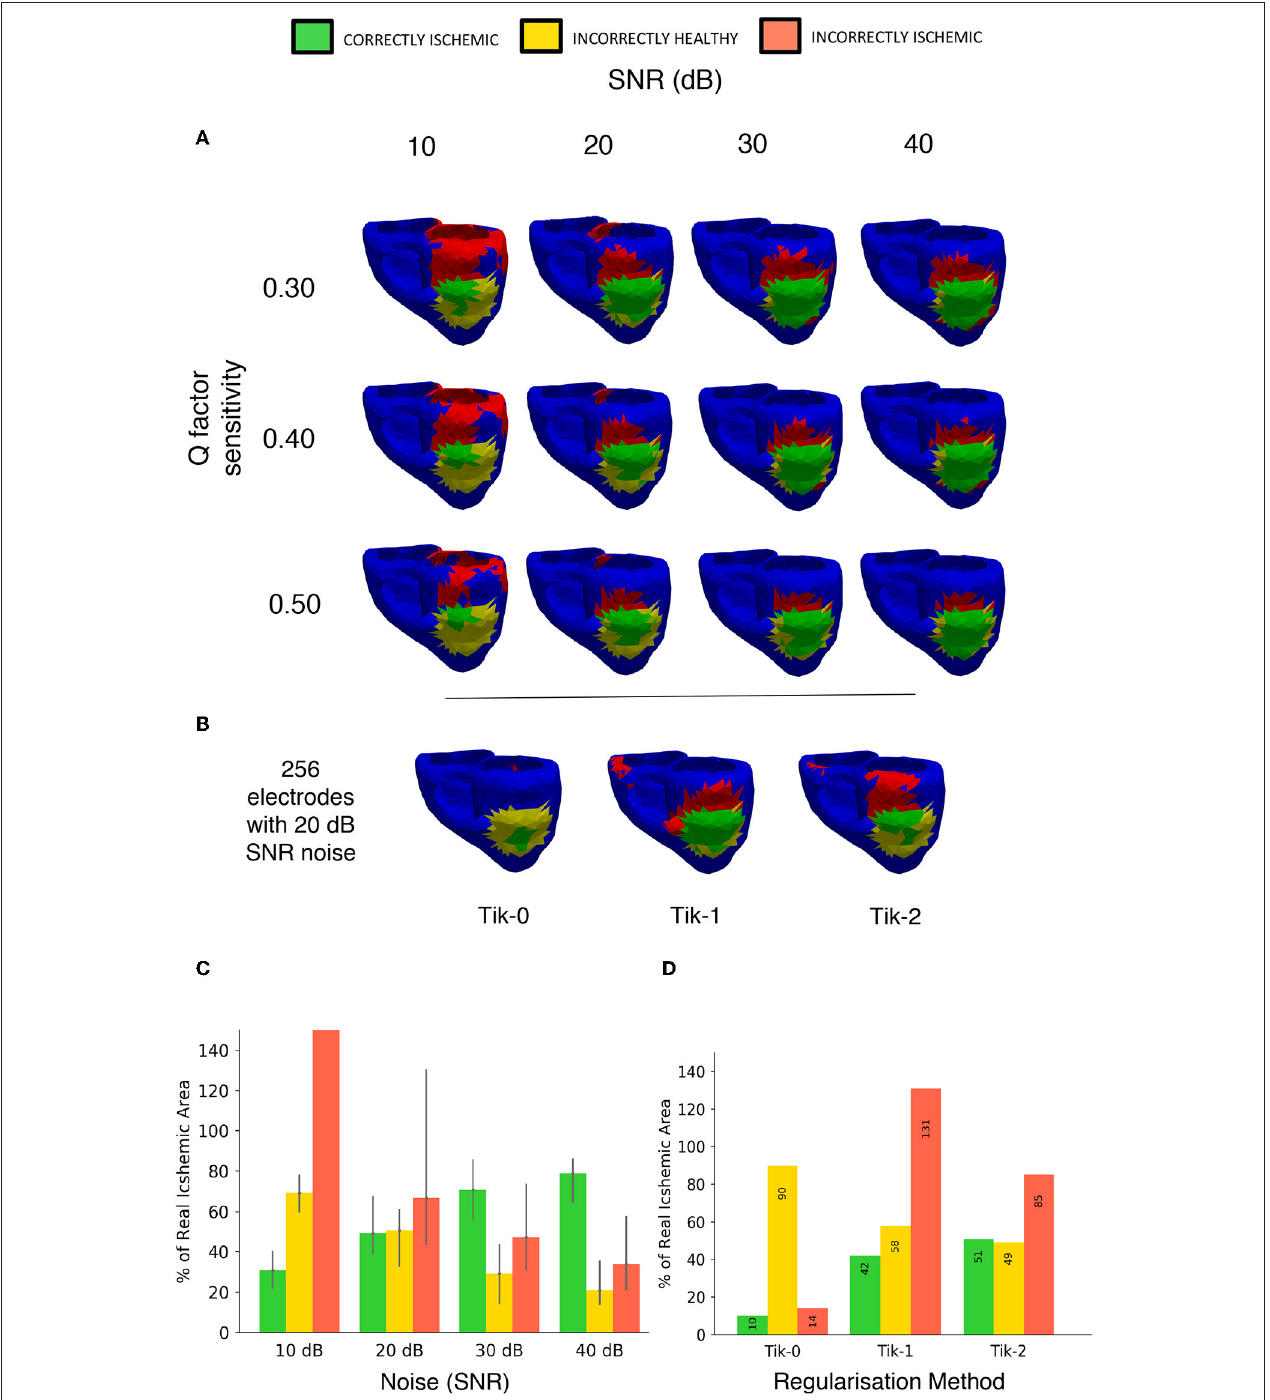
FIGURE 11 | Noise and sensitivity analysis on the lesion detection results and Tikhonov regularisation performance results including 20 dB SNR. (A) Signal to Noise ratio (10, 20, 30, 40 dB) vs. lesion threshold algorithm sensitivity with the lesion located on the left ventricle anterior wall. (B) Detection results using the 3 different regularisation techniques constructed from BSP’s containing noise at 20 dB SNR using 256 electrodes layout. (C) Bar chart visualizing the “traffic light” data taken from (A) over the whole geometry. Bar height represents data taken from the Q = 0.4 in Equation (7) with error bars on the bar showing results of setting Q from 0.3 to 0.5. (D) Bar chart visualizing the “traffic light” data taken from (B) over the whole geometry.